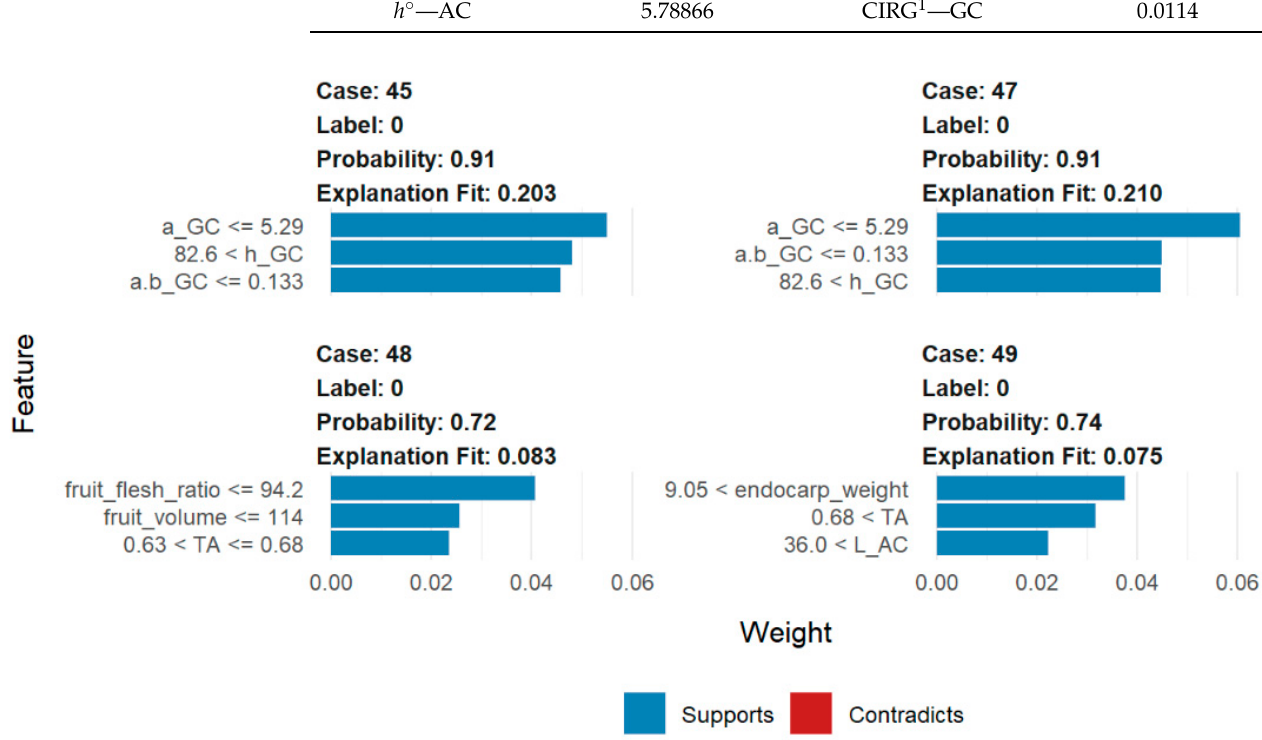
Figure 4. Four random LIME predictions on the Model B dataset. (Due to the inability to use special characters in the programming language, feature names are slightly modified, as described in Appendix A . )